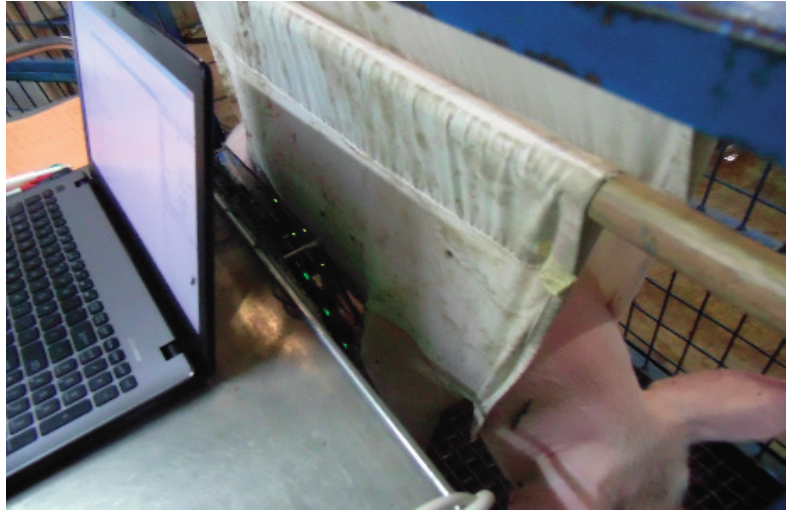
Figure 15. Pig under test with the tracking